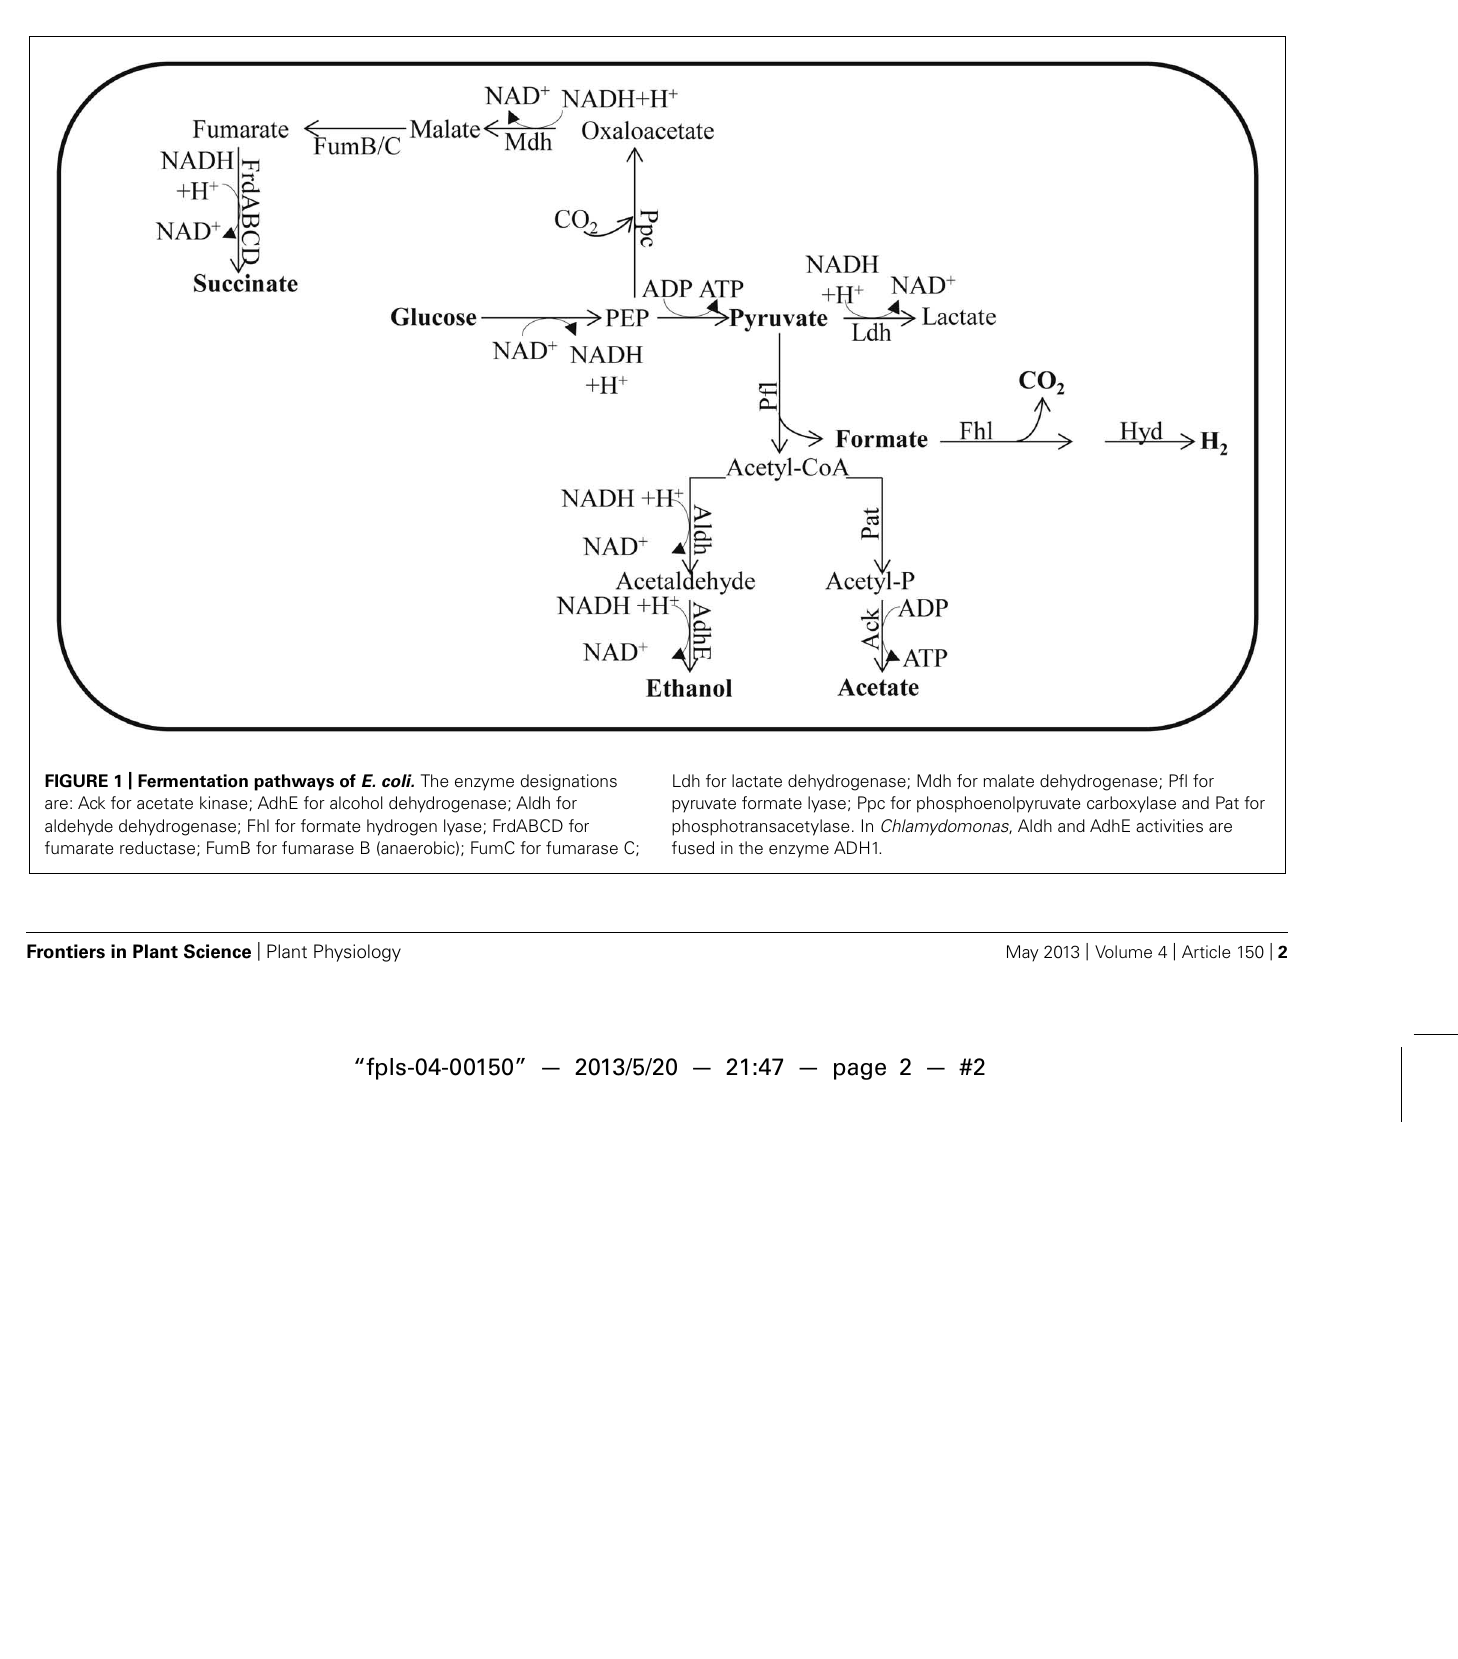
Frontiers in Plant Science | Plant